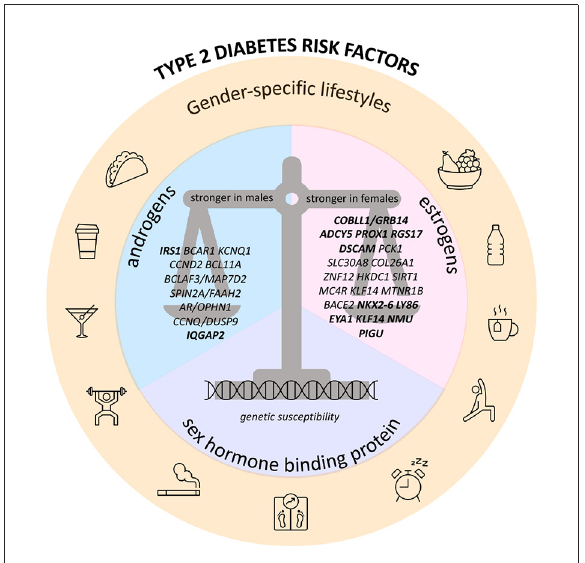
FIGURE1 Recap figure depicting sex-specific genetic determinants of type 2 diabetes and glucose-related traits, and their interaction with endogenous/exogenous sex hormones, sex hormone binding protein, and gender-specific lifestyle factors. Hereby are presented the genes with sex-dimorphic effect on risk of T2D and/or GDM and/or FG and/or FI; genes in bold also have sex-dimorphic effect on BMI or